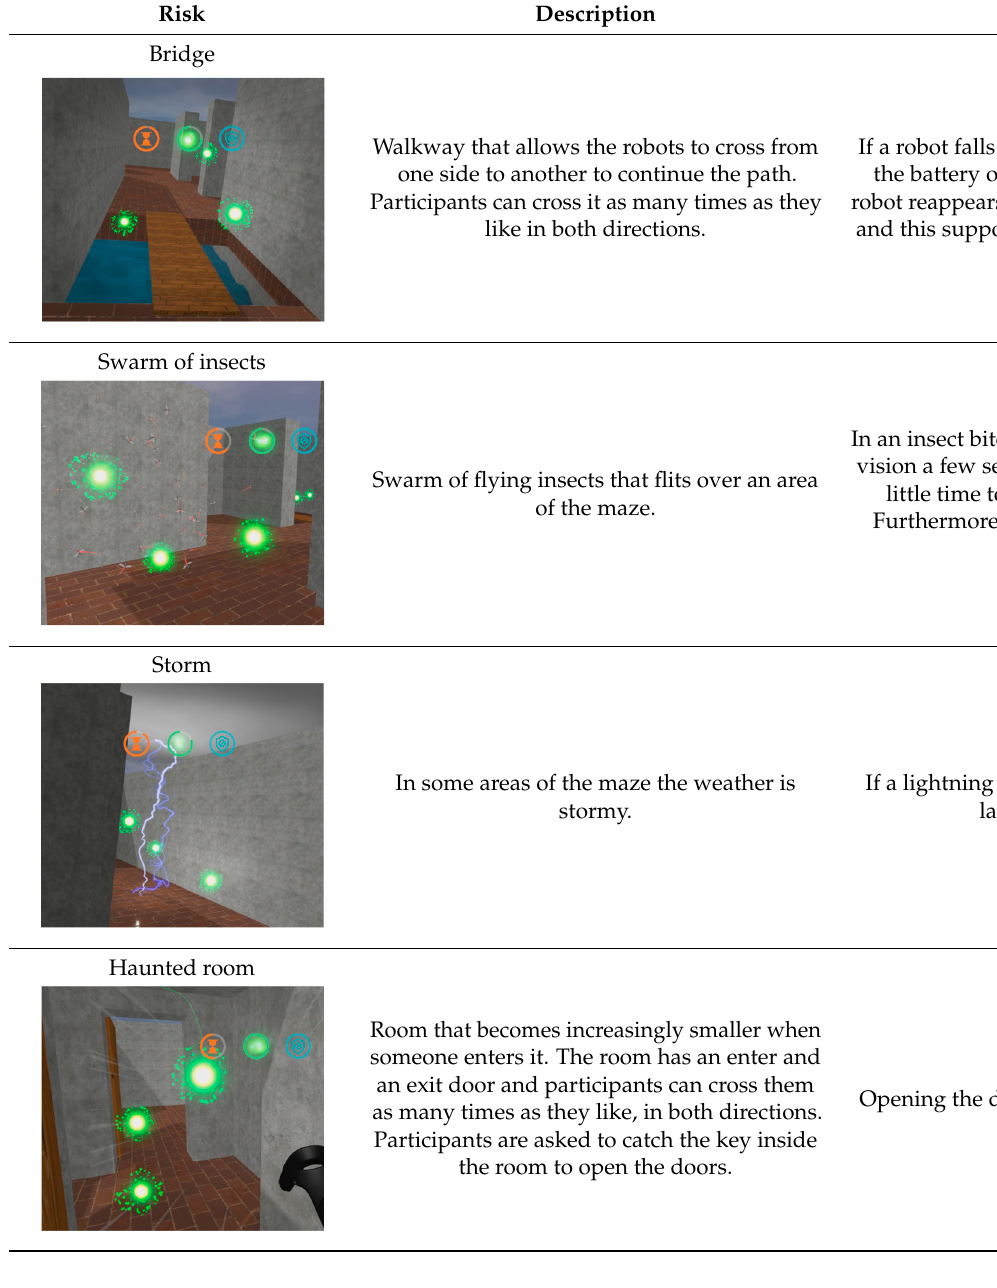
Table 1. Description of the risks.